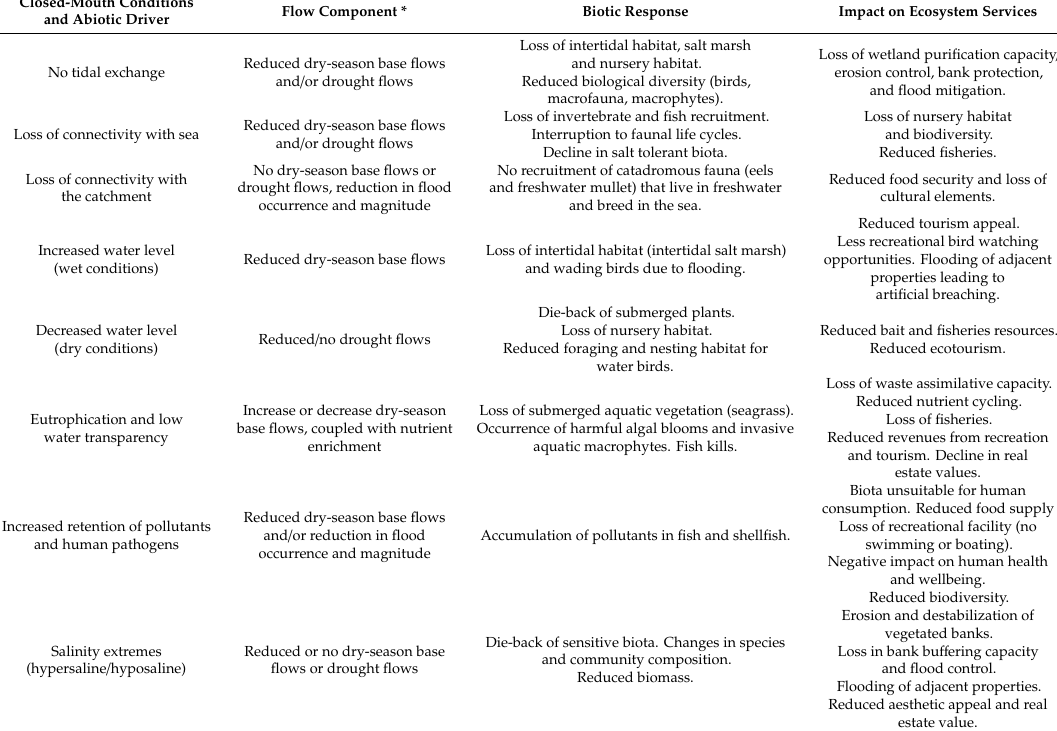
Table 1. Response of temporarily closed estuaries (TCEs) to reduced freshwater inflow and increased duration and frequency of closed-mouth conditions in terms of resultant abiotic drivers, the main flow component driving the process, biotic responses, and impacts on ecosystem